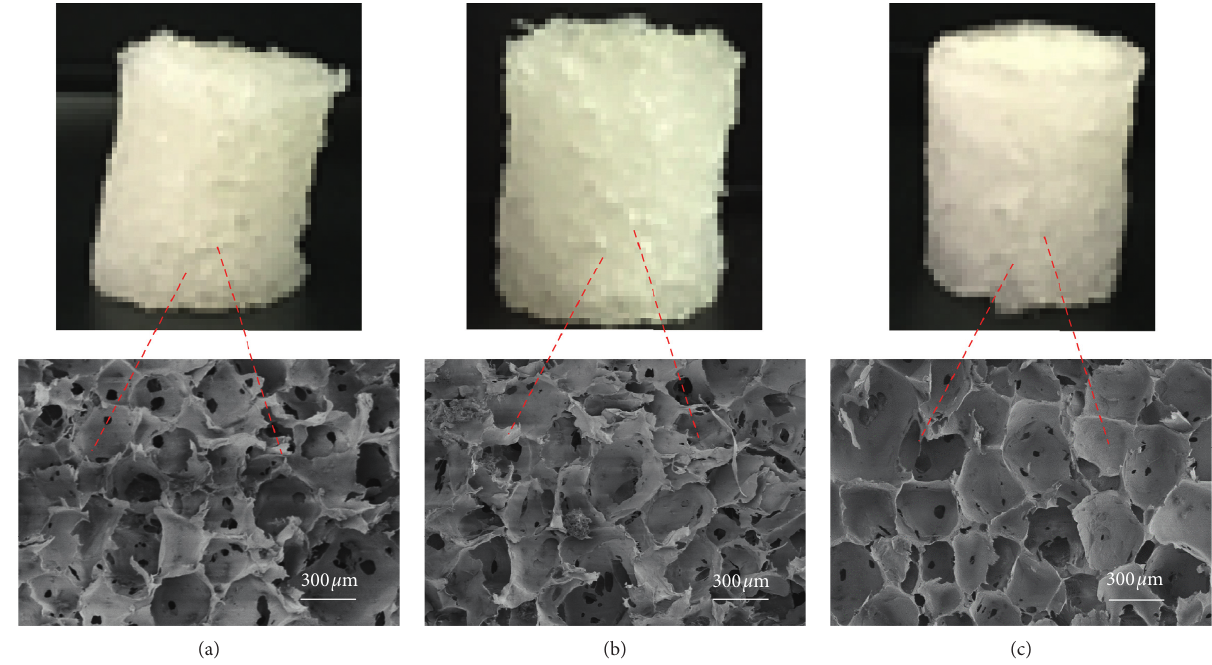
Figure 2: SEM images of the cross section of porous scaffolds rinsed with methanol (a), ethanol (b), and water (c).